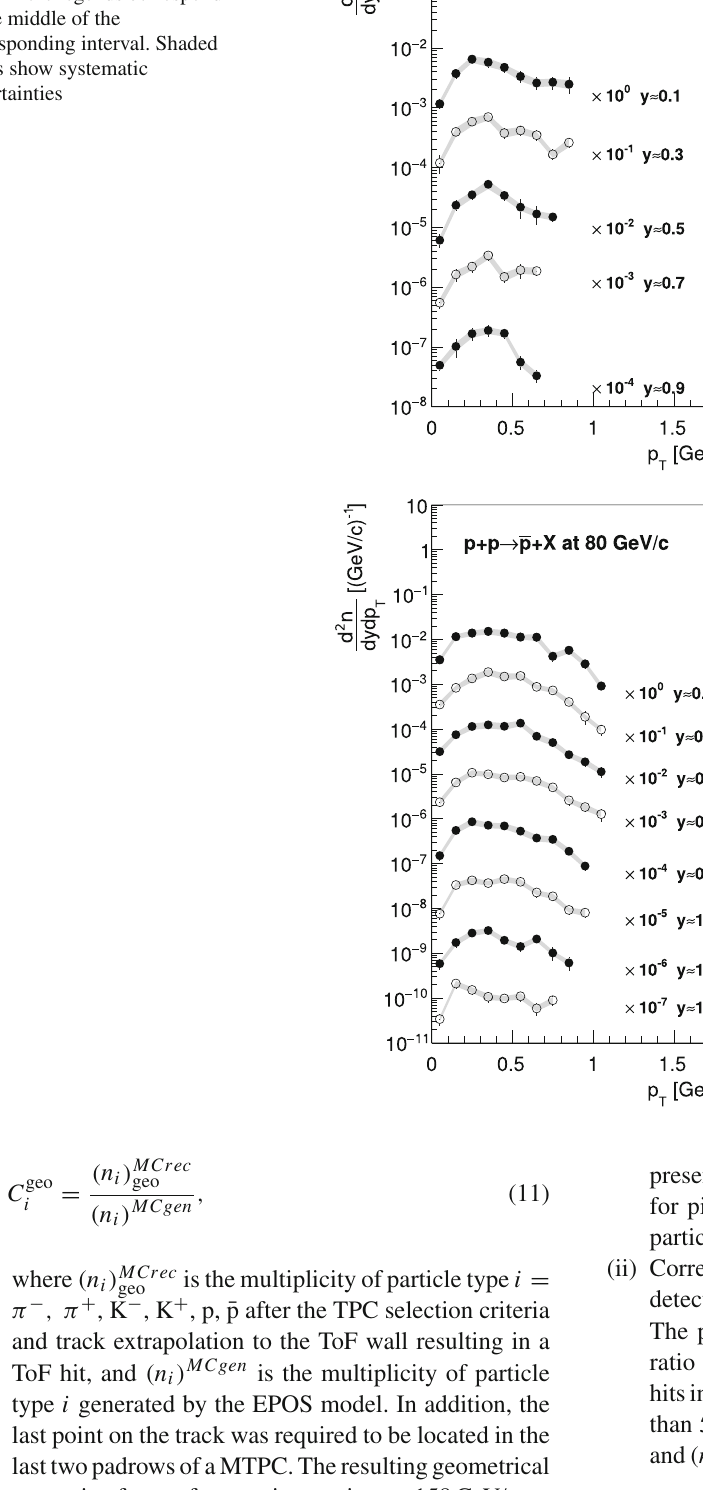
Fig. 31 Transverse momentum ¯ p spectra in rapidity slices produced in inelastic p + p interactions at 20, 31, 40, 80, 158 GeV / c . Rapidity values given in the legends correspond to the middle of the corresponding interval. Shaded bands show systematic